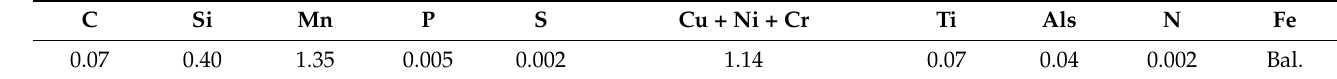
Table 1. Chemical composition of the test